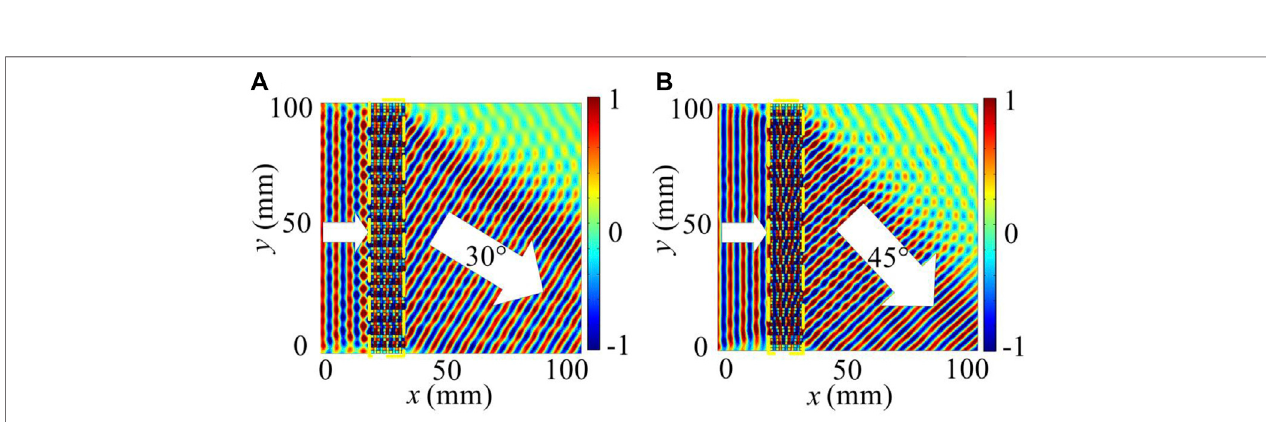
FIGURE 2 | Directional ultrasound emission with the planar metasurface (indicated by the yellow dashed boxes) consisting of 80 units along the y -direction. The ultrasound at 300 kHz normally incident from the left are refracted by 30 ° in (A) and 45 ° in (B) .